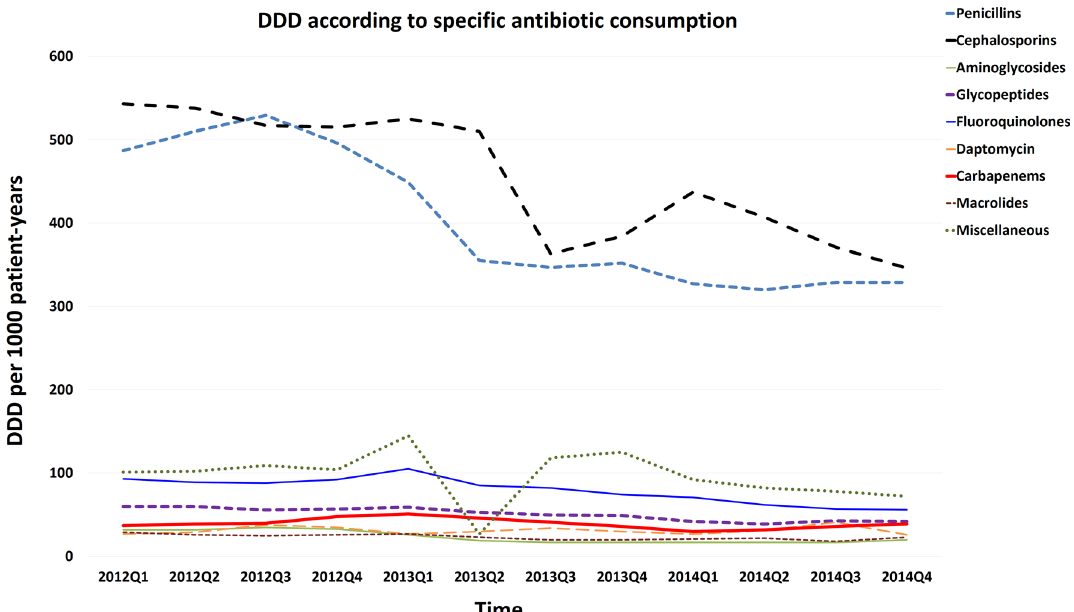
Figure 3. Trends of antibiotic consumption according to specific antibiotics. The major consumed antibiotics showed more prominent trend in DDD decline, whereas carbapenems, although were relatively low consumed, did not show a decrease trend (red line).